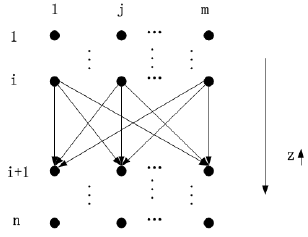
Figure 3. The way of IACO for spectrum